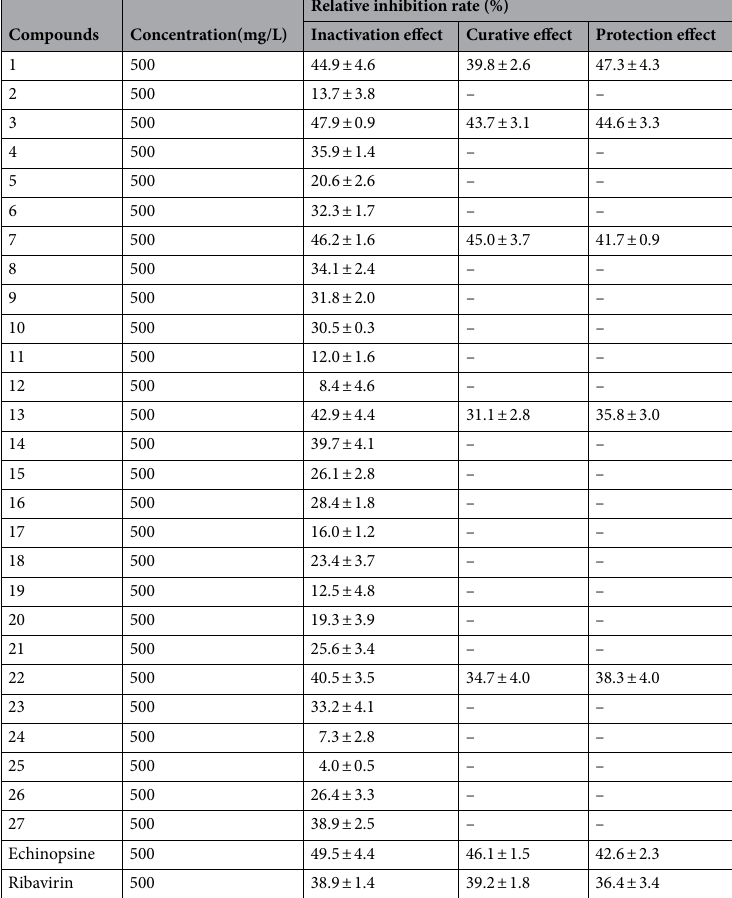
Table 1. In vivo antiviral activities of compounds 1 – 27 and echinopsine against